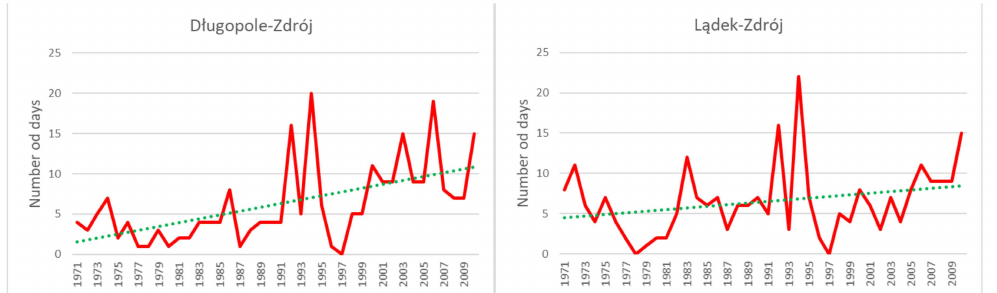
Figure 5. Annual number and linear trend of days with strong and very strong heat stress (UTCI > 32 ◦ C) in Długopole-Zdr ó j and L ˛adek-Zdr ó j in 1971–2010, based on 12:00 UTC data.